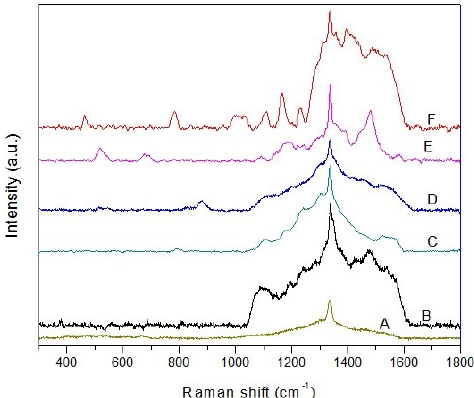
Figure 3. Raman spectra of diamond deposited using different silicon concentrations. A: 0 atom %; B: 0.11 atom %; C: 0.52 atom %; D: 0.98 atom %; E: 1.41 atom % and F: 1.81 atom %.